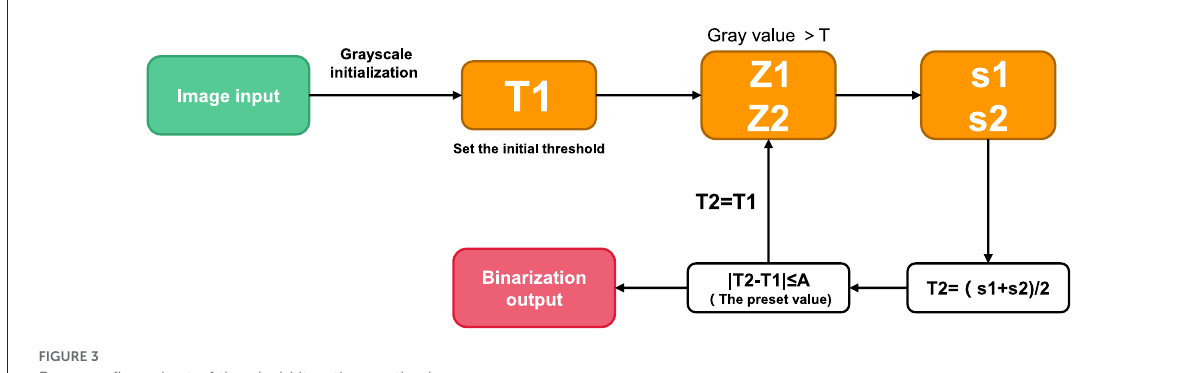
FIGURE3 Program flow chart of threshold iteration method.